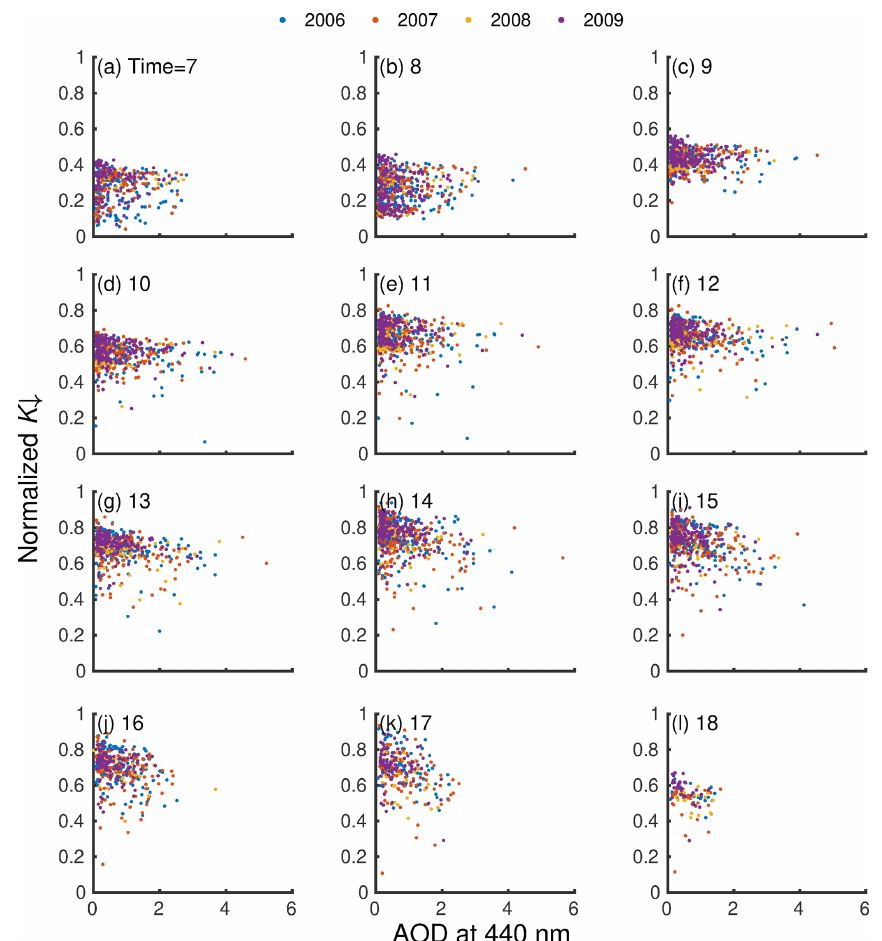
Figure 2. As Fig. 1 but for the uncorrected WFDEI incoming solar radiation ( K ↓ ).